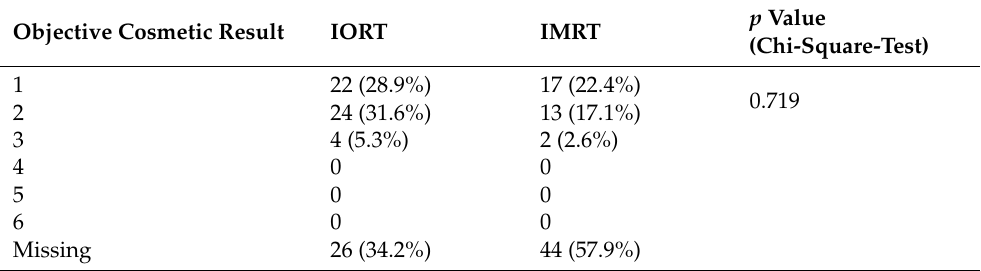
Figure 3. Graphic representation of the comparison of the subjective cosmetic result collected during follow-up to the objective cosmetic result collected during follow-up classified by the treating physician, one graph for ( a ) IORT subgroup and one for ( b ) IMRT subgroup. The columns represent the number of cases. Table 5. Objective cosmetic result evaluated by physicians during radiotherapy series, scale equal to school grades (1: very good,.6: